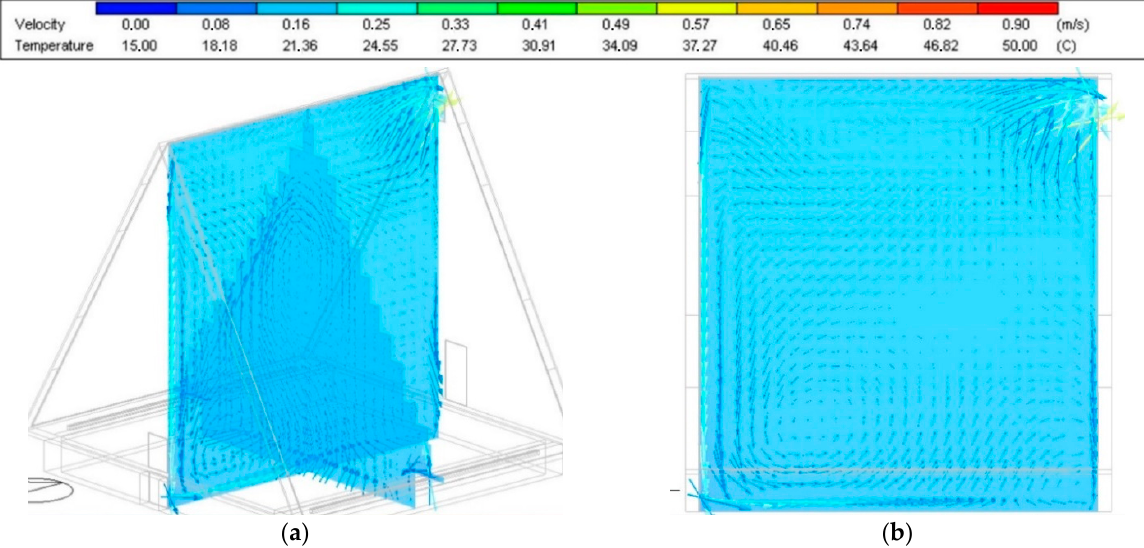
Figure 21. Simulated airflow paths on 6.6. at 6:00 a.m. in position of: ( a ) transverse sections; ( b ) longitudinal section.